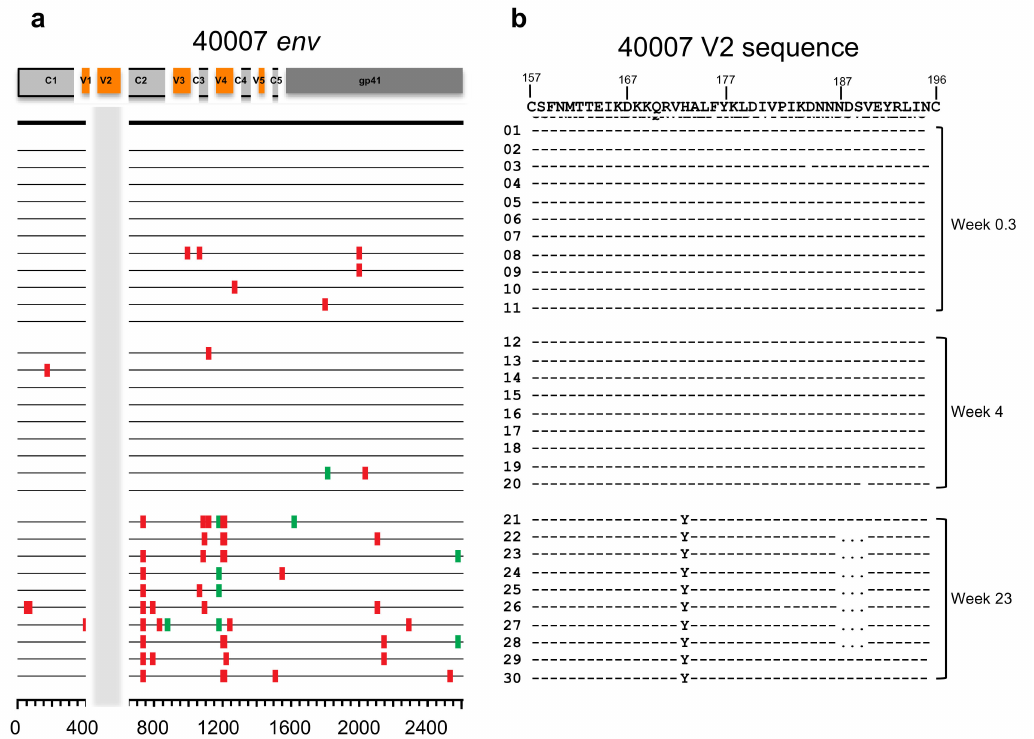
Figure 2. HIV-1 env and V2 sequences of RV217 participant 40007 at weeks 0.3, 4, and 23 post-infection. ( a ) Highlighter plot of HIV-1 env sequences from participant 40007 with changes from the consensus sequence (black line on the top represents the inferred T / F sequence at week 0) demarcated by red (synonymous) or green (non-synonymous) vertical markers. The V2 region is indicated by the vertical orange bar. ( b ) Sequence alignment of the HIV-1 Env V2 protein sequence from ~10 single-genome amplification (SGA) sequences for each time point. Sequence variation are indicated by the newer variant amino acid letter, and deletions are indicated by dots. The numbers on the master sequence show the HXB2